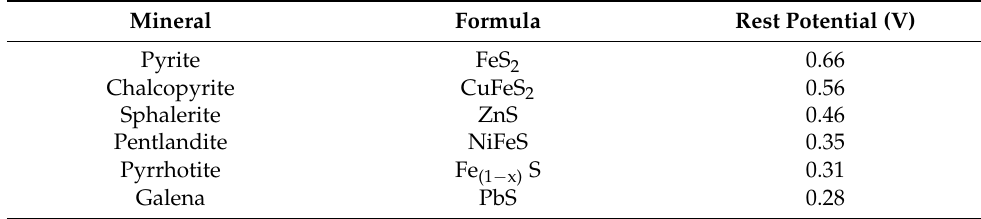
Table 4. Rest potential values for some sulphide minerals [17].